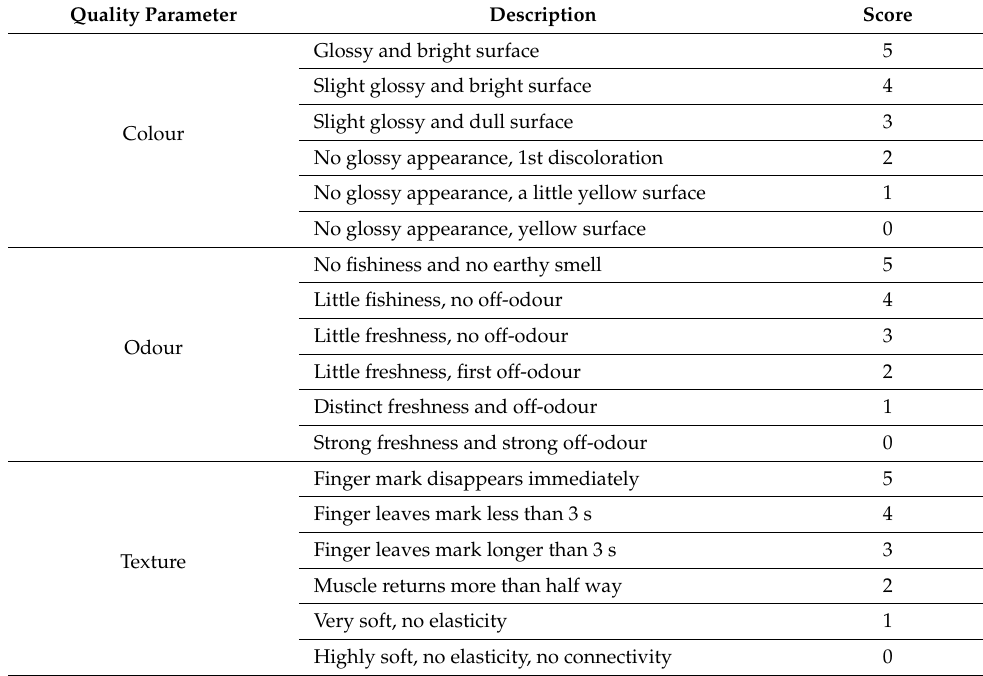
Table 2. Sensory evaluation